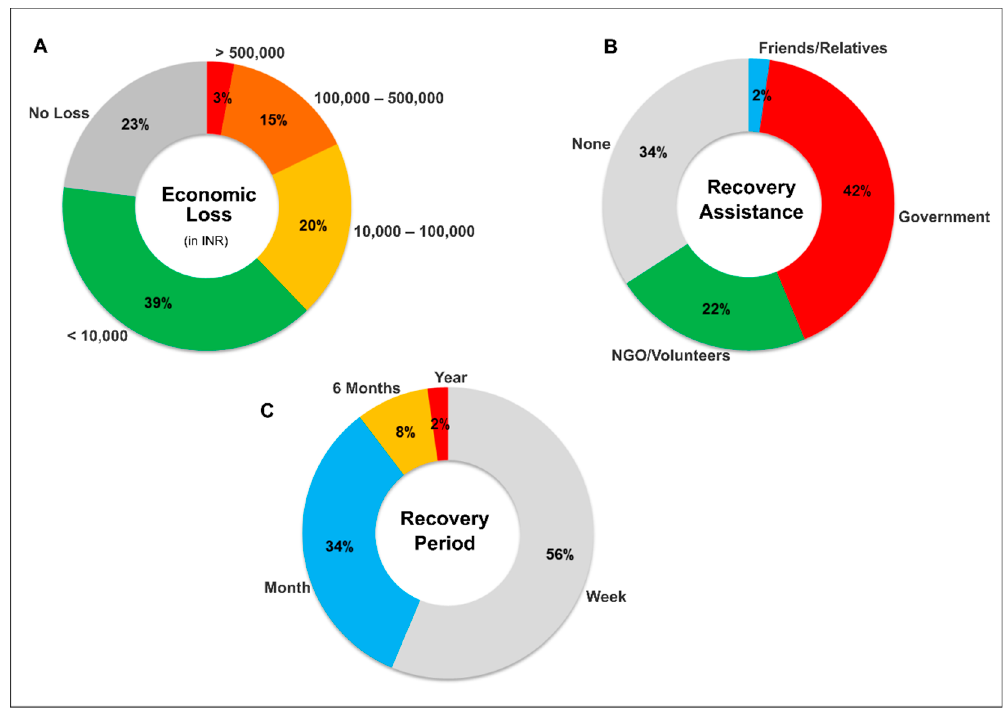
Figure 8. Spatial distribution of perceptions on ( A ) flood challenges, ( B ) flood damage, ( C ) flood exposure, ( D ) flood loss, and ( E ) flood frequency.